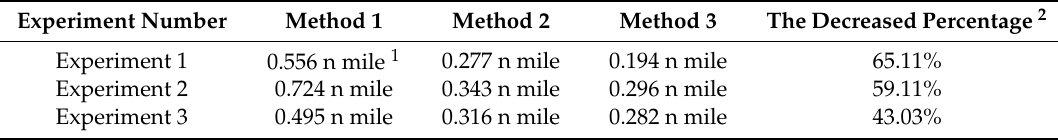
Table 10. The maximum position errors of the vehicle navigation experiment.